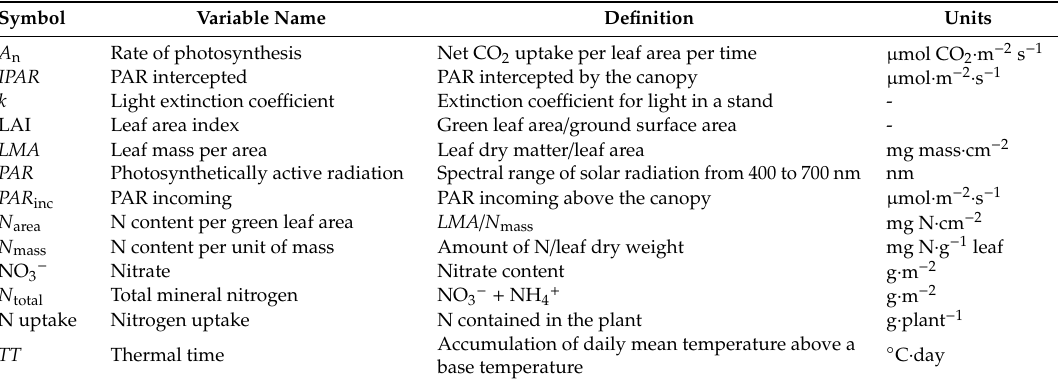
Table 1. List of abbreviations, as well as their definitions and